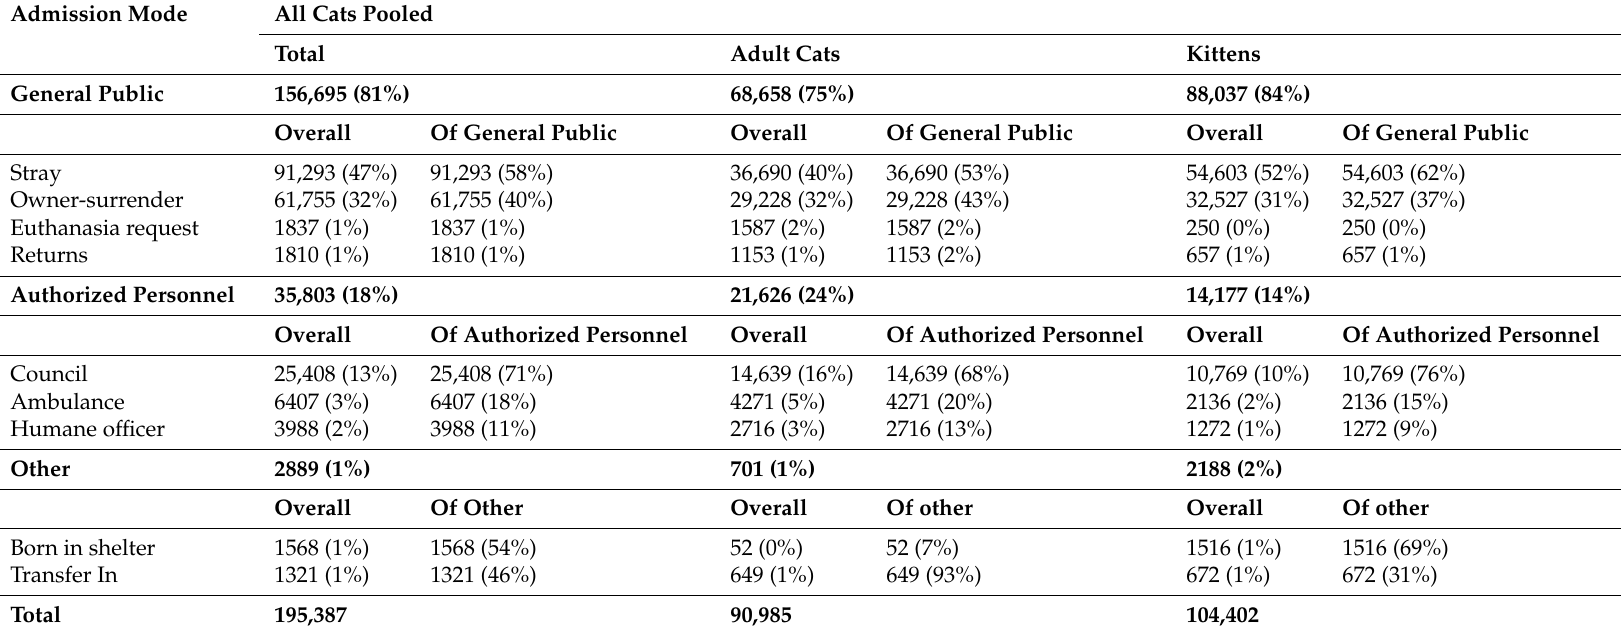
Table 2. Distributions of admissions to 39 RSPCA shelters between June 2006 and July 2010 by admission mode and